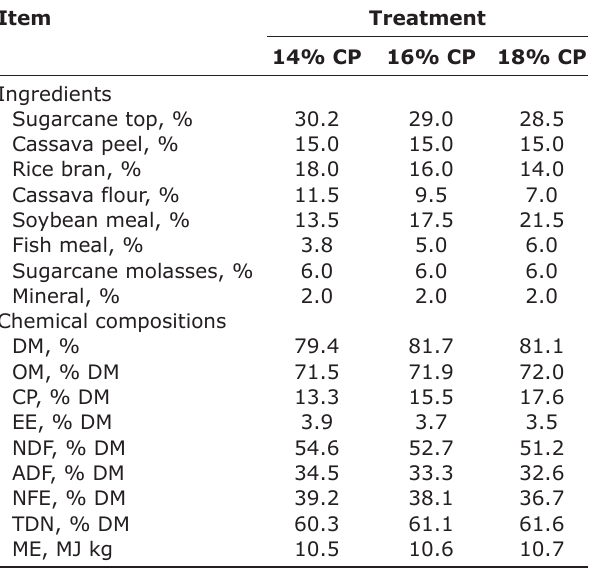
Table-1: Dietary ingredients and nutrient content of experimental diets (DM basis). Item